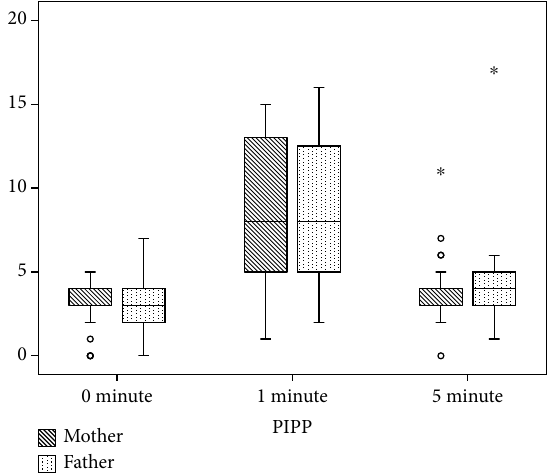
Figure 2: Group comparisons of PIPP scores at di ff erent time points. PIPP: premature infant pain pro fi le